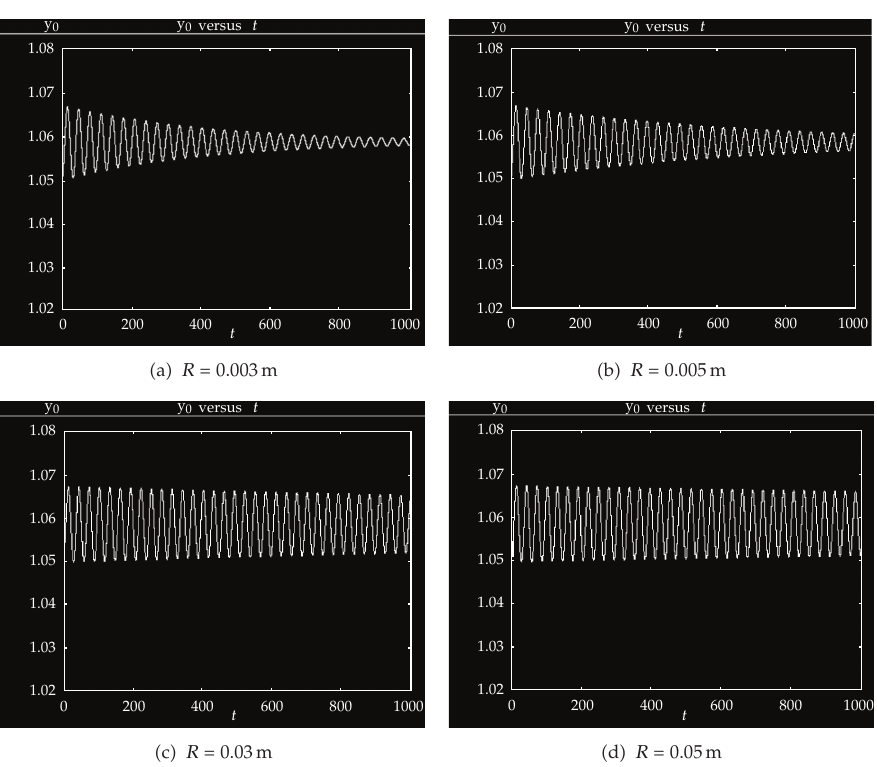
Figure 6: Stretch ratio for viscoelastic model with varying radii.